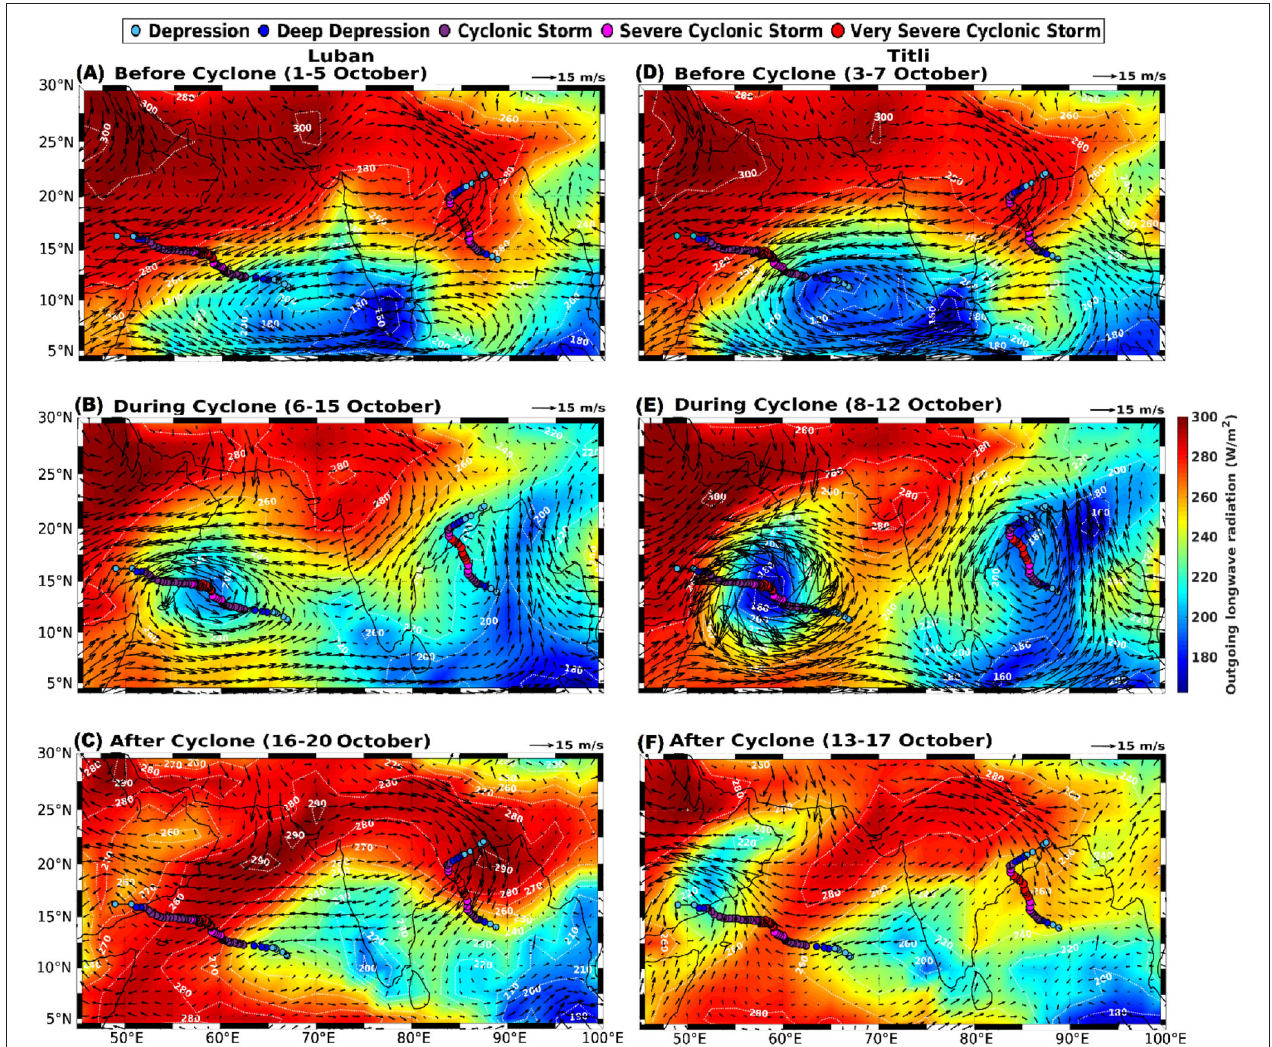
FIGURE 9 | A spatial map of outgoing longwave radiation (W/m 2 ), overlaid with 850 hPa wind (m/s) before (A,D) , during (B,E) , and after (C,F) cyclones Luban (A–C) and Titli (D–F) . The color-filled circles denote the cyclone tracks.